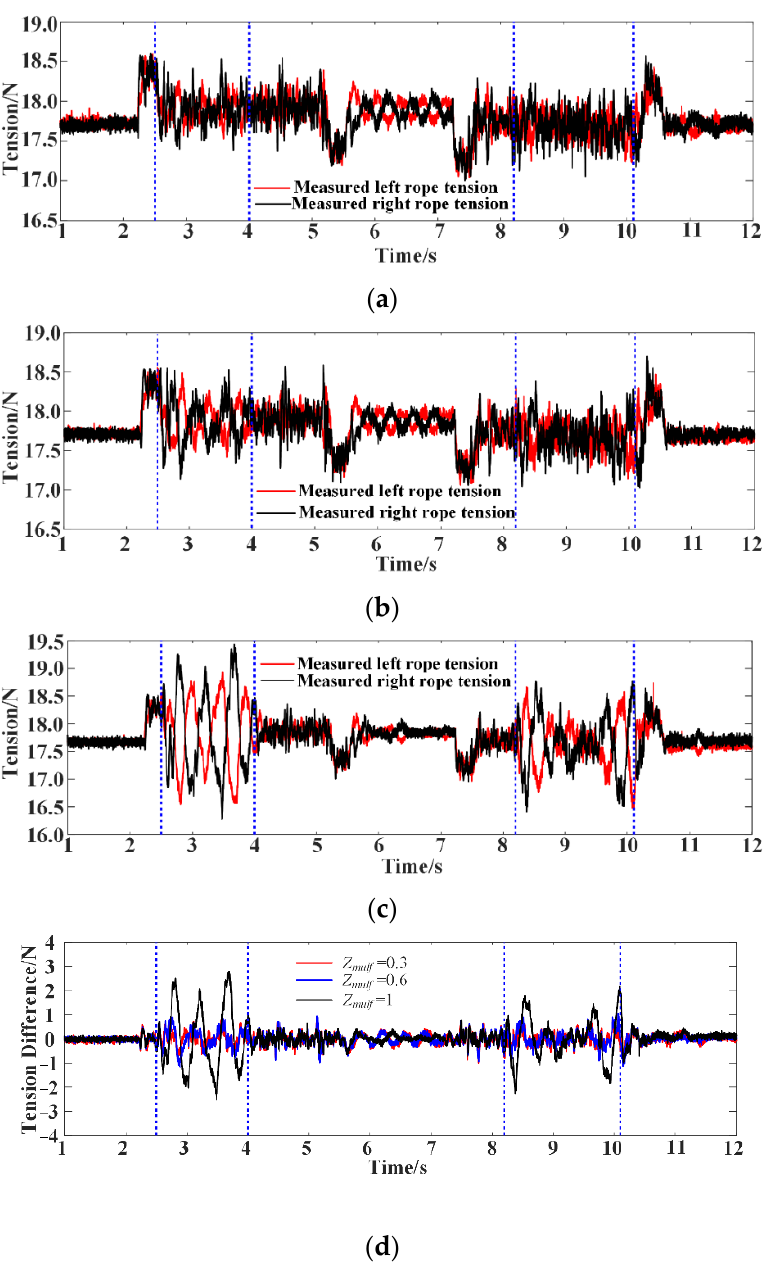
Figure 8. Measured rope tension and tension difference under fault condition with AFSMC: ( a )